Question: Provide a one-line summary of what is displayed.
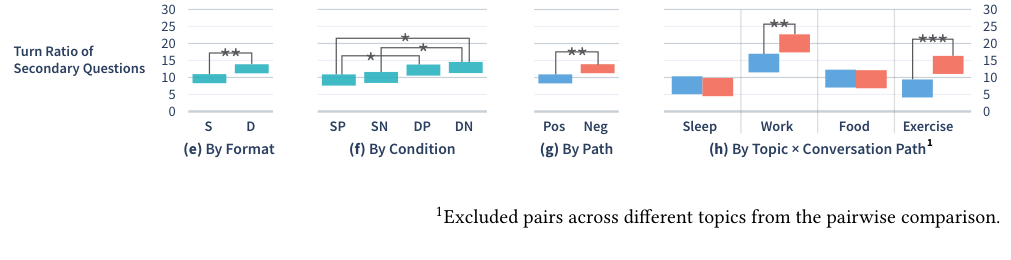
Answer: 95% confidence intervals of the turn ratios of RQ (top; a–d) and SQ (bottom; e–h) by variables with a significant effect: The asterisks with arms indicate significance between the connected categories. Note that for (d) and (h) we did not display the significance across topics. (Refer to Appendices A.4.1 and A.4.2 for model details and statistics.)